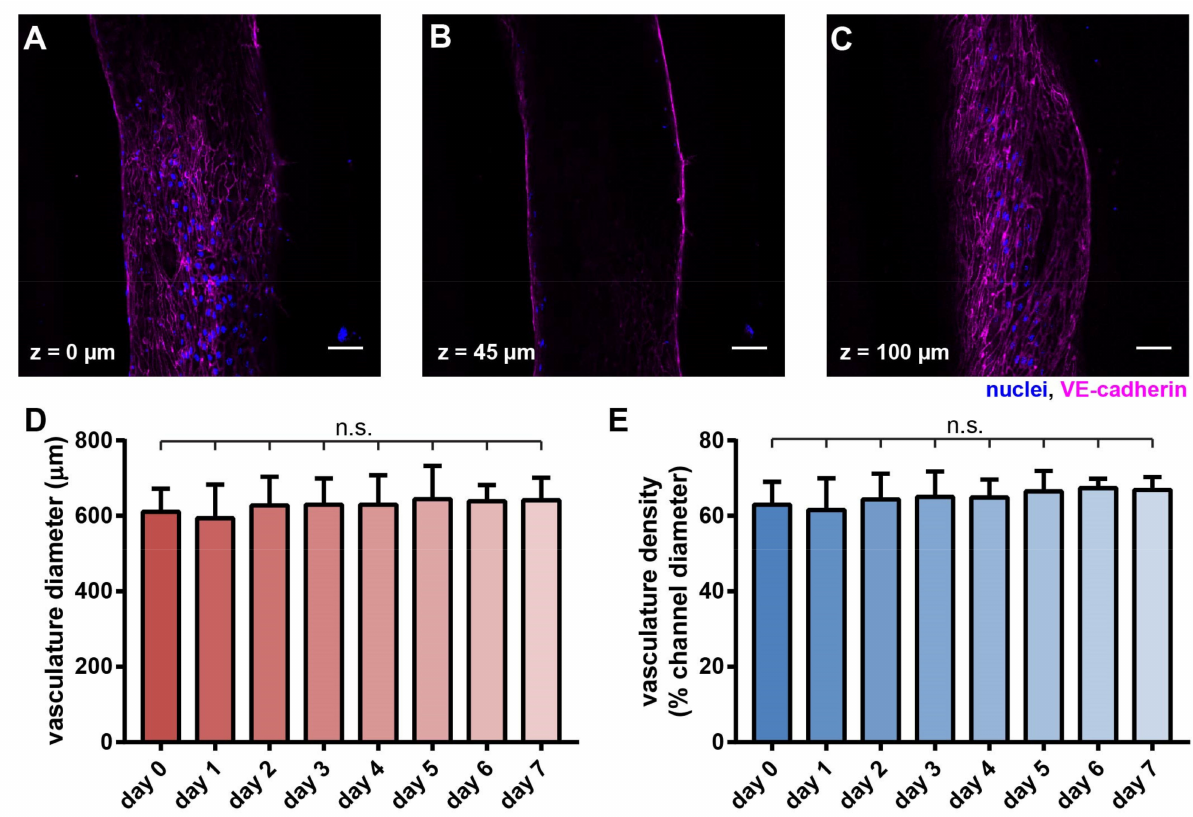
Figure 3. Morphological characterization of the vasculature in the hypoxic tumor model. Confocal scans of the vascular cross-sections at ( A ) z = 0 µ m, ( B ) z = 45 µ m, and ( C ) z = 100 µ m, respectively. Scale bars: 50 µ m. ( D ) Vascular diameter and ( E ) vascular density were maintained over 7 days. ( D , E ) n = 12, 14, 15, 15, 9, 9, 6, 6 for day 0~7, respectively. N.s.: not significant, with one-way